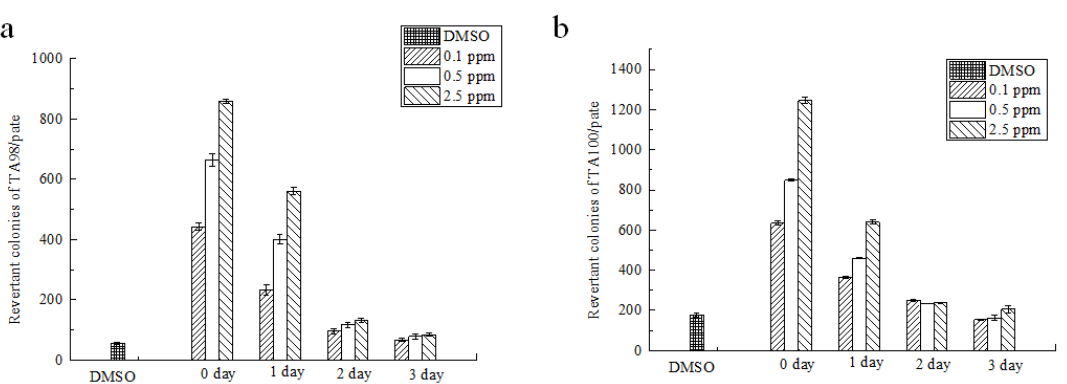
Figure 6. The results of mutagenicity of AFB 1 degradation products (+S9); Note: Figure ( a , b ) is mutagenicity of the degradation products of strains TA98 and TA100 after degradation for different times at initial AFB 1 concentrations of 0.1, 0.5, and 2.5 µ g/mL, respectively.